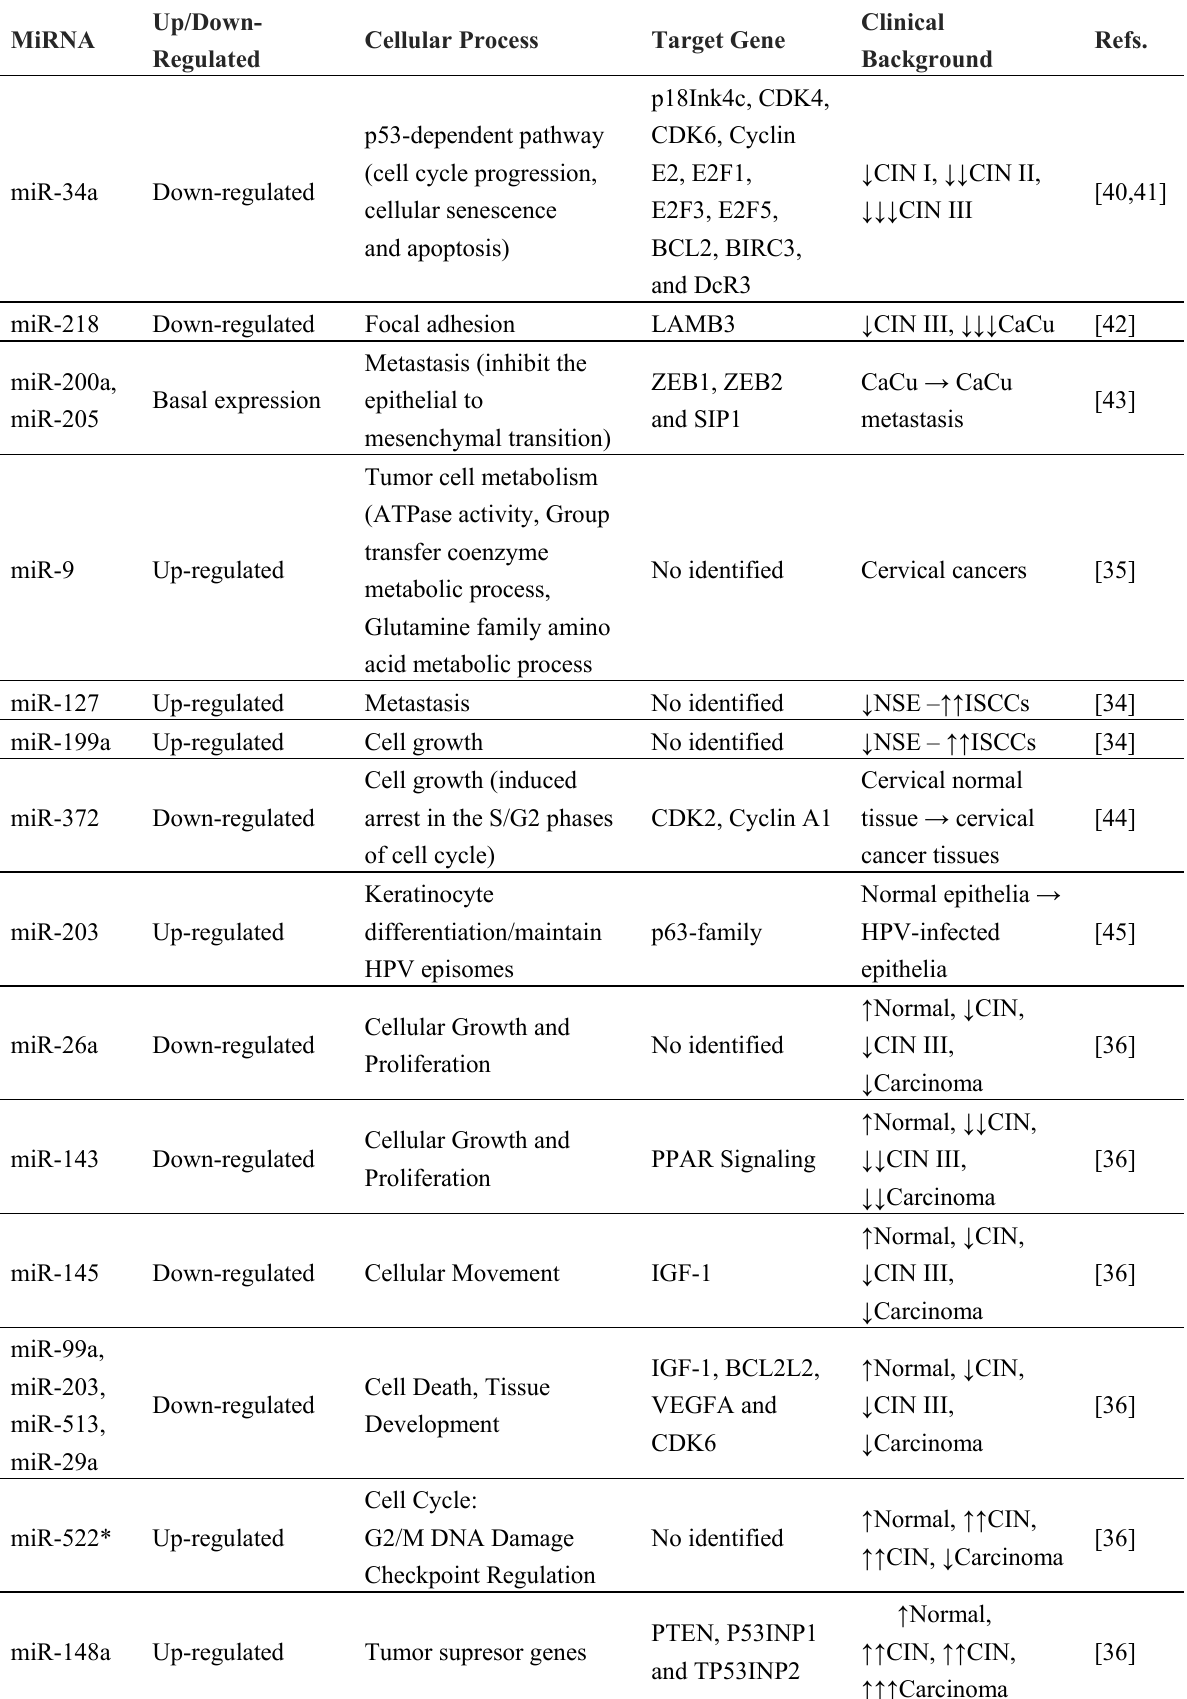
Table 1. MiRNAs involved in the development and progression of cervical cancer. MiRNA